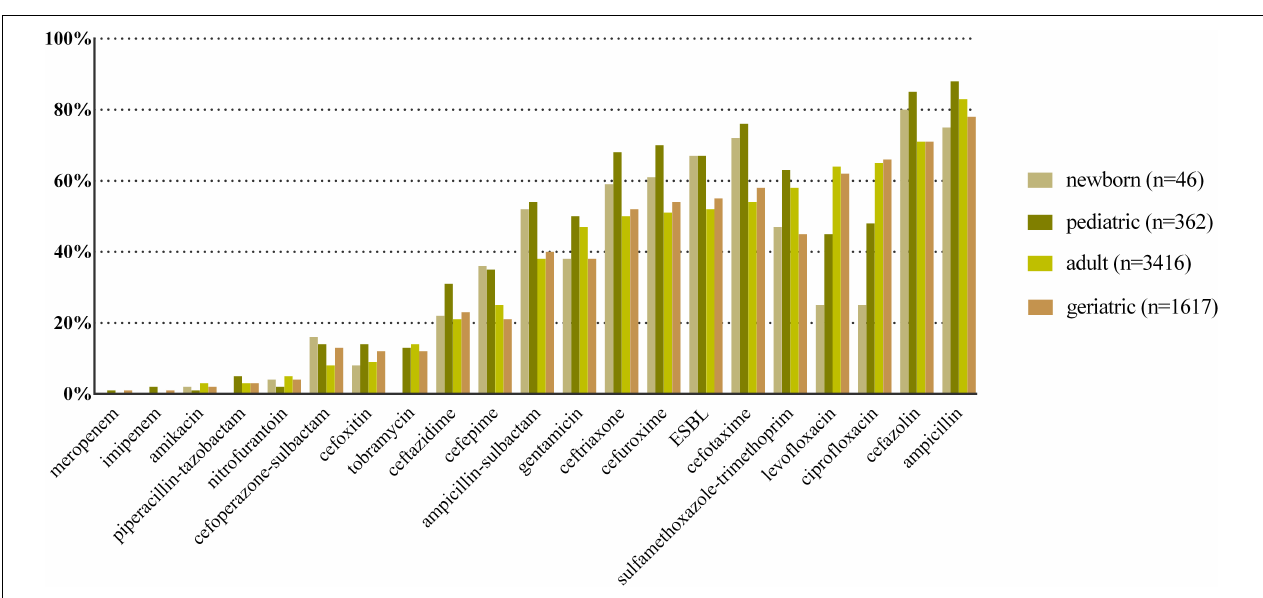
FIGURE 2 | Antibacterial resistance rates of urinary E. coli in different age categories. X -axis: different antibiotics tested for urinary E. coli , Y -axis: Antibiotic resistance rate.